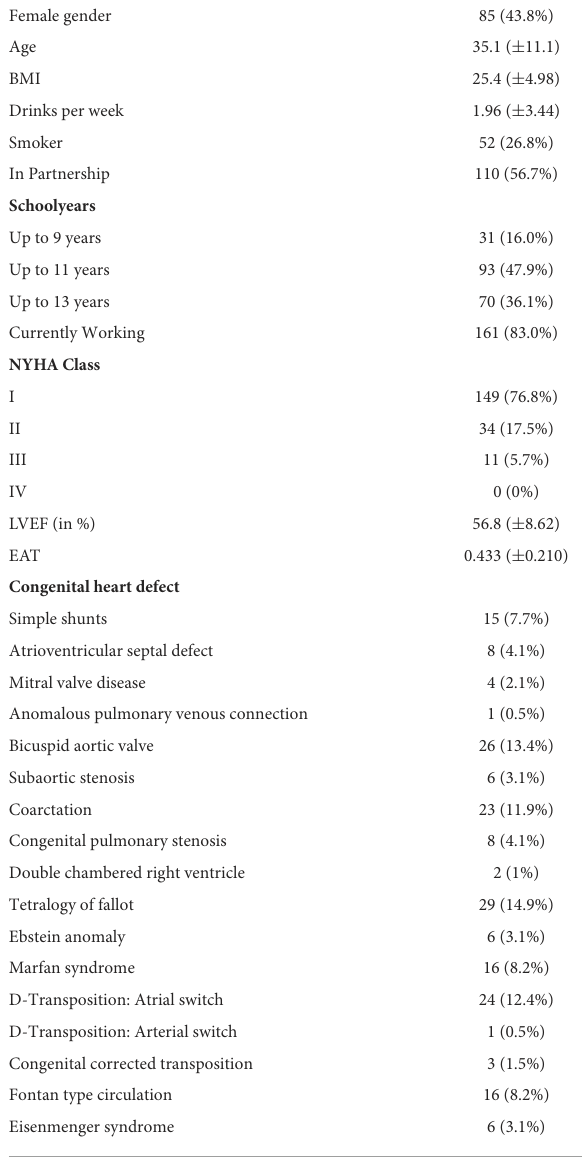
TABLE 1 Sociodemographic and cardiological data of the sample